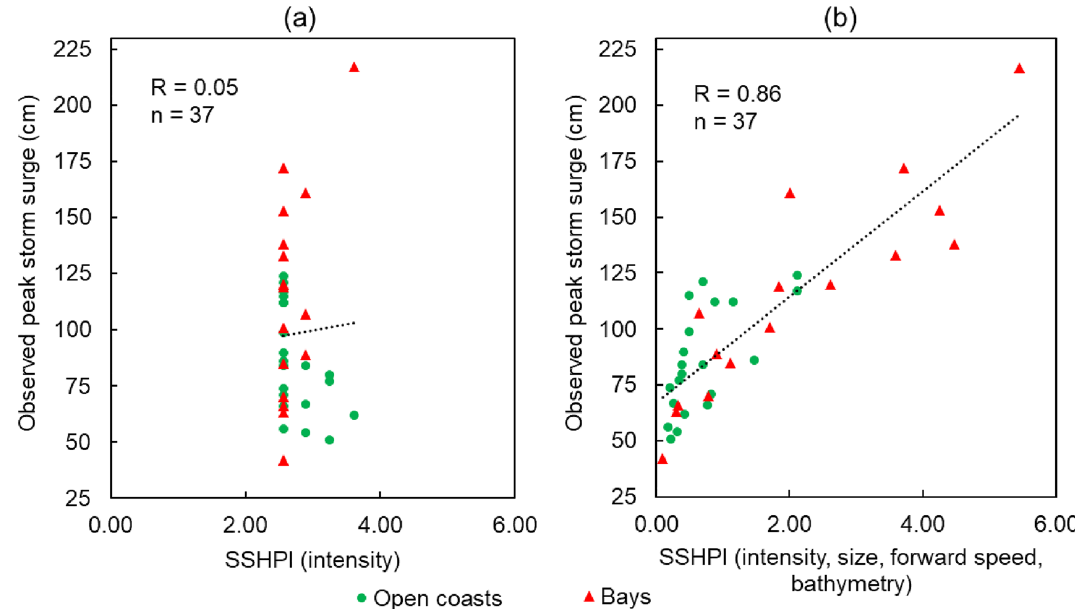
Figure 8. TC intensity-based ( V max ≥ 80-kt, during landfall time frame) definition of major storm surges versus (a) SSHPI as a function of intensity; (b) SSHPI as a function of intensity, size, forward speed, and bathymetry; Dashed line shows the correlation gradient of the respective surge and